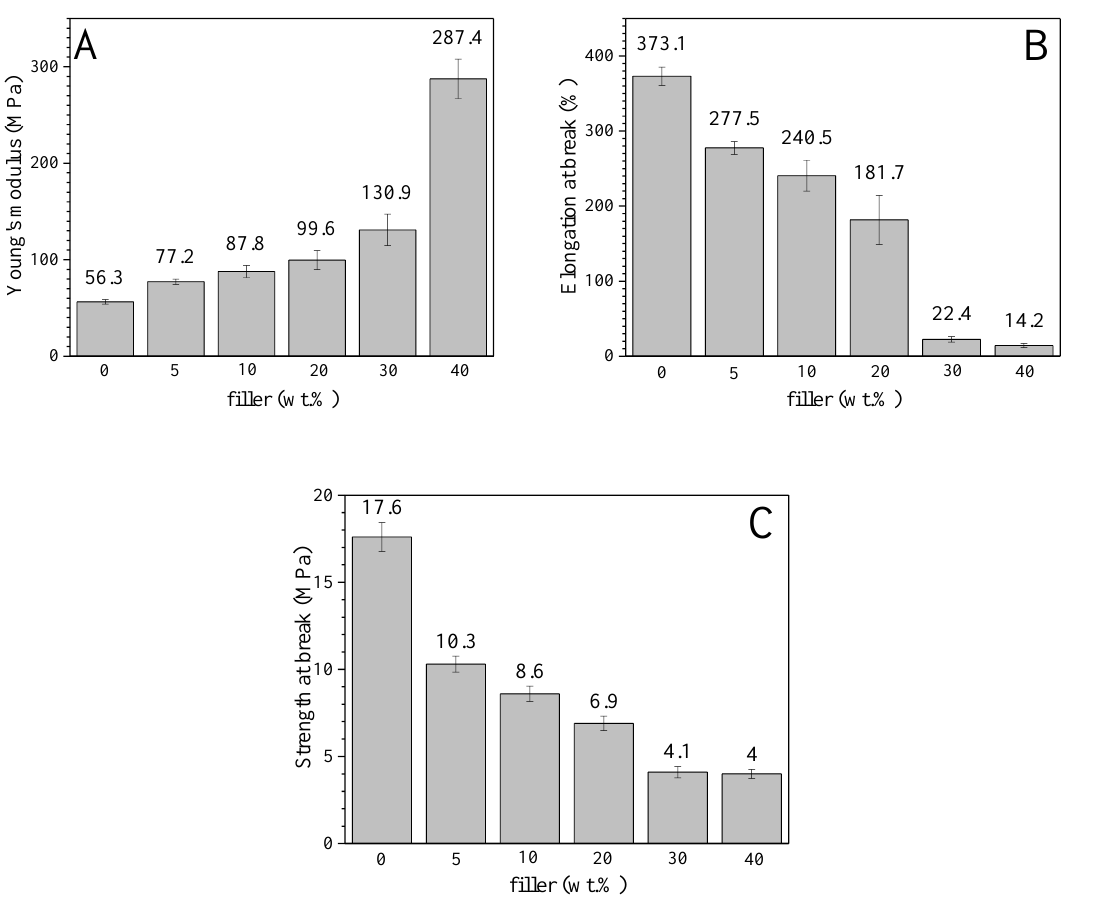
Figure 7. Tensile mechanical behavior of EVA/HFB composites: ( A ) Young’s modulus (MPa); ( B ) elongation at break (%); ( C ) tensile strength (MPa).